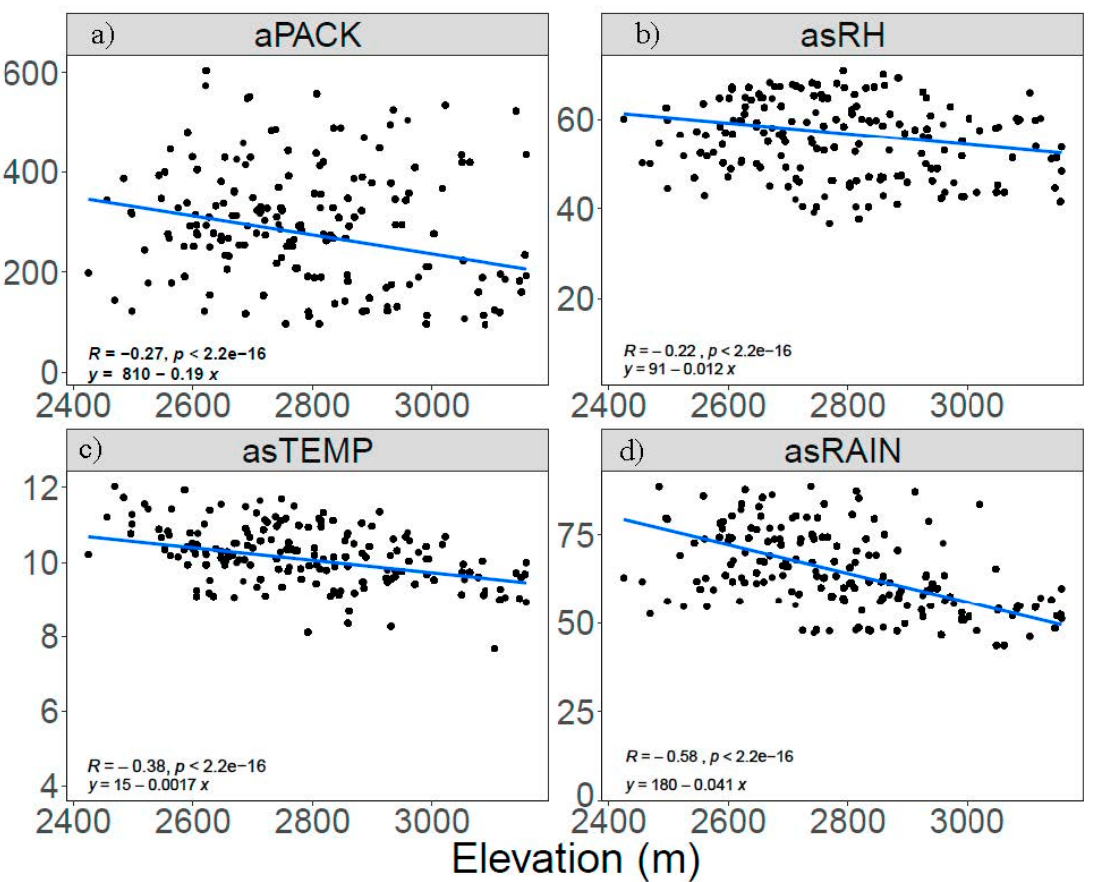
Figure 3. Relationships at monitored whitebark pine stands between elevation and climate variables ( a ) maximum annual snowpack snow water equivalent, aPACK (mm); ( b ) August–September mean relative humidity, asRH (%); ( c ) August–September mean temperature, asTEMP ( ◦ C); ( d ) August–September cumulative rain, asRAIN (mm) used in the climate class of models of white pine blister rust infection in the GYE.